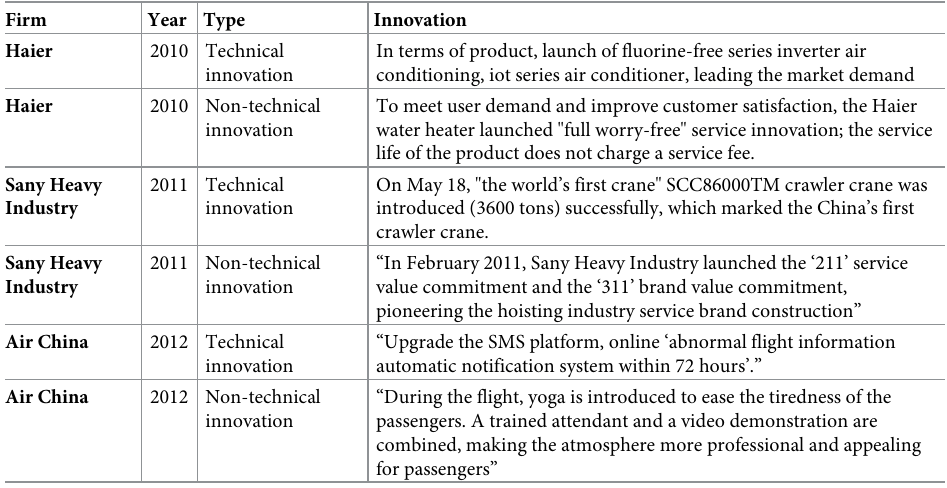
Table 2. Examples of technical innovation and non-technical